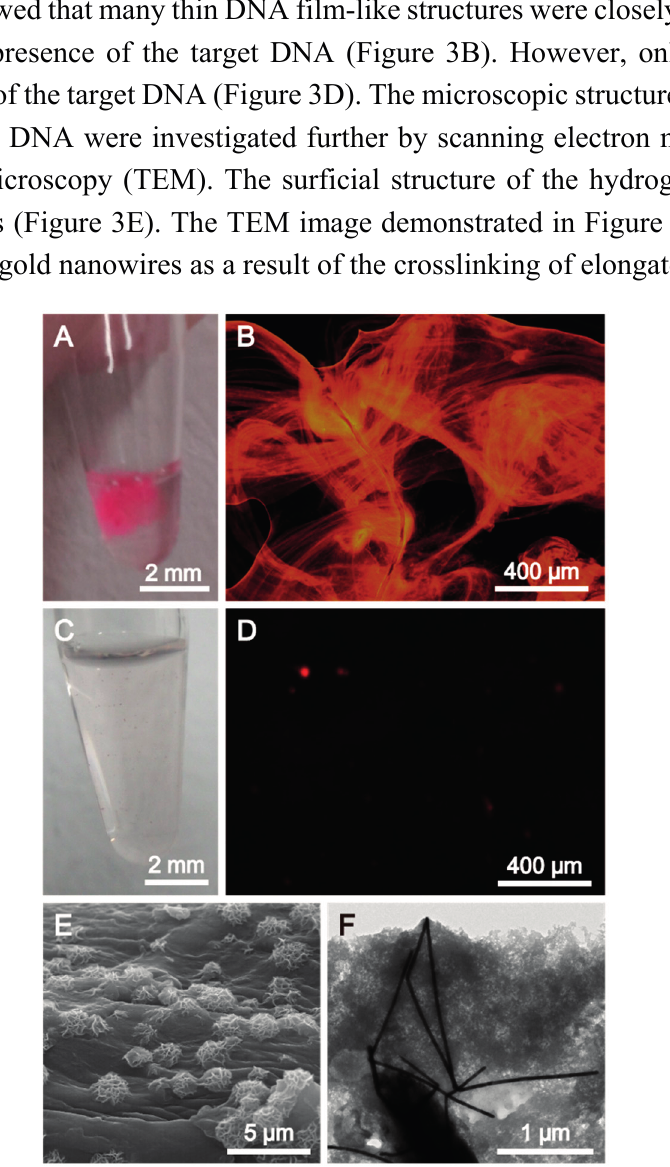
Figure 3. ( A–D ) Digital camera images and fluorescence microscopy images of the products of rolling circle amplification in the presence ( A , B ) and absence ( C , D ) of the target DNA; ( E ) SEM and ( F ) TEM images of the AuNW-DNA hydrogel after rolling circle amplification with the target